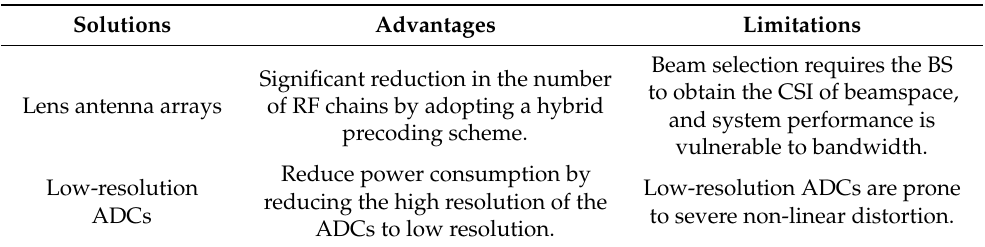
Table 1. Multiple solutions to the problem of overwhelming hardware costs and power consumption in mmWave massive MIMO system.